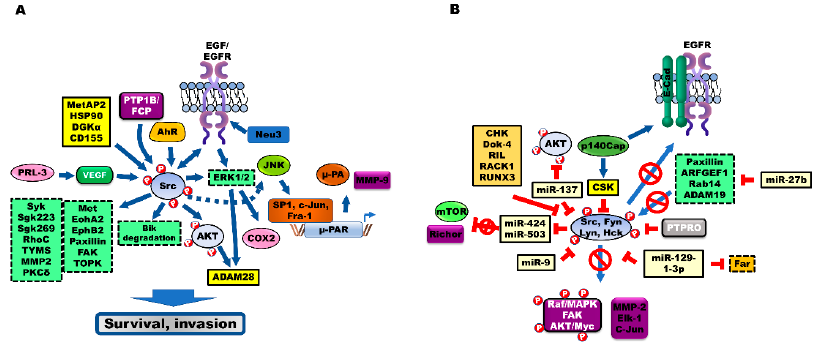
Figure 2. Modulators and suppressors were regulating Src activation during the progression of colorectal cancer (CRC). ( A ) Several cellular components positively promote the progression of CRC through Src activation. The expression levels of aryl hydrocarbon receptor (AhR), receptor-type protein tyrosine phosphatase (PTPR; PTP1B, RPTP α , and PRL-3), MetAP2, Neu, HSP90, DGK α and CD155 are upregulated in patients with CRC. These components activate Src and its downstream target signaling to enhance survival, invasion and chemoresistance of CRC cells. ( B ) Cell proliferation and metastasis of CRC cells are inhibited by inhibiting the activation of Src by multiple intracellular regulators, including C-terminal Src Kinase (CSK), protein tyrosine phosphatases (PTPRs), protein tyrosine phosphatase receptor type O (PTPRO), protein tyrosine phosphatase receptor type T (PTPRT), microRNAs (miRNAs), CSK-homologous kinase (CHK), downstream of tyrosine kinase-4 (Dok-4), reversion-induced LIM (Lin-1, Isl1, Mec3) (RIL), Receptor for activated C kinase 1 (RACK1), and RUNX family transcription factor 3